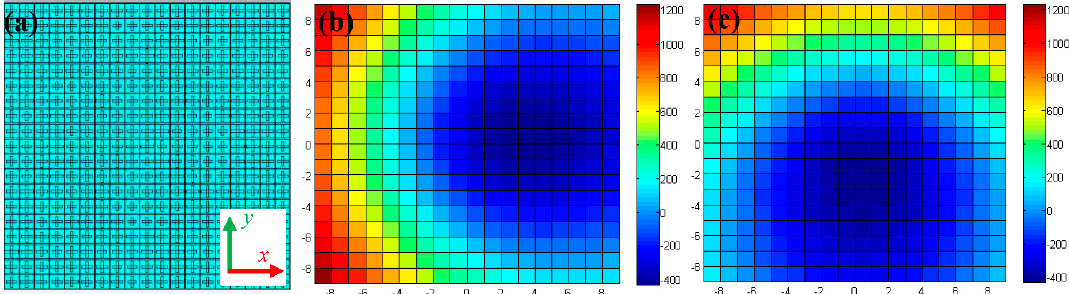
Figure 6. ( a ) The designed metasurface. The phase distributions for ( b ) the x - and ( c ) y -polarized components.